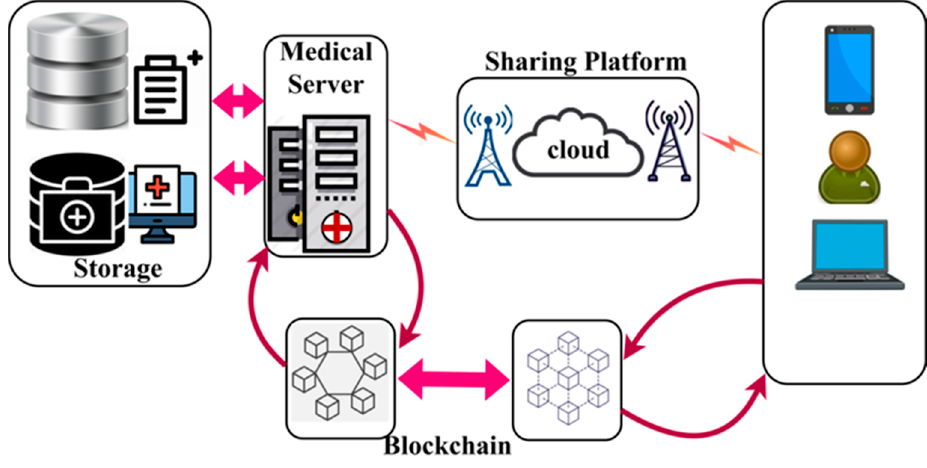
Figure 1. Biomedical Security System with blockchain.